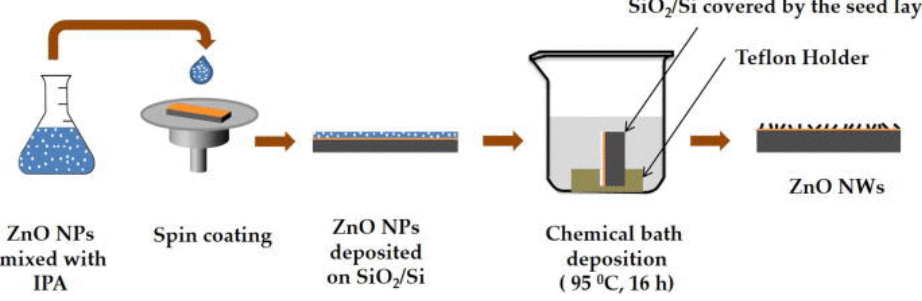
Figure 9. Schematic representation of the two-step method of the chemical bath deposition process. Reproduced with permission from